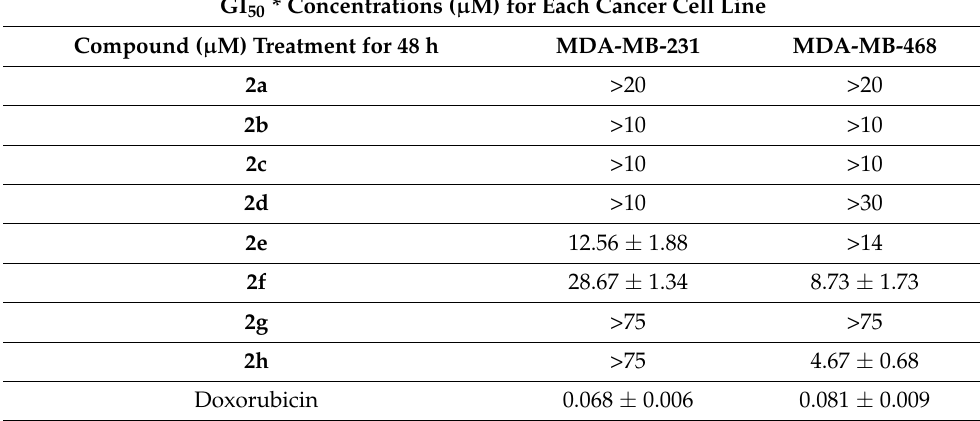
Table 2. GI 50 concentrations of compounds 2a – 2h in two different triple negative breast cancer cells, determined with SRB assay. GI 50 * Concentrations ( µ M) for Each Cancer Cell Line Compound ( µ M) Treatment for 48